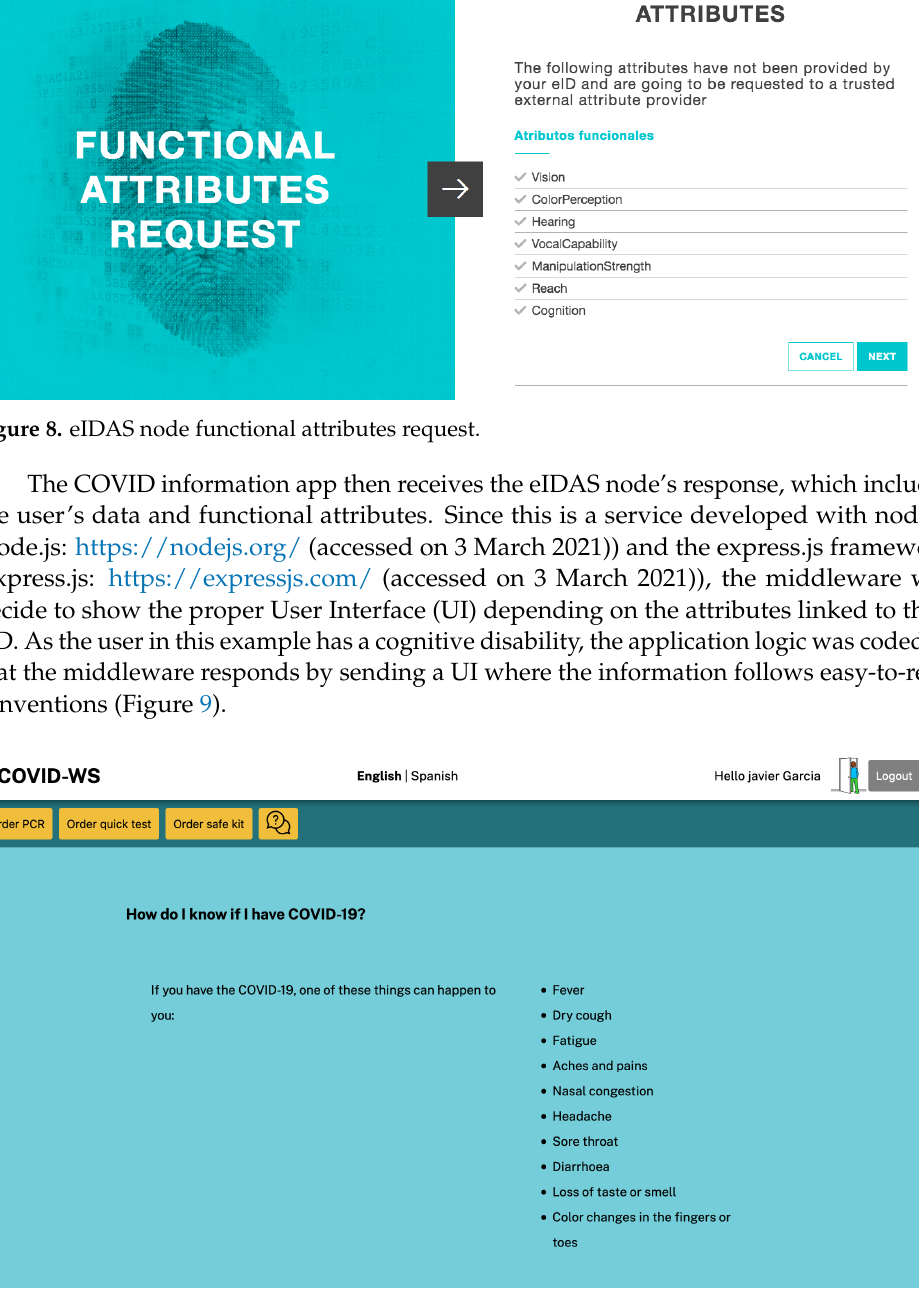
Figure 9. COVID information service adapted to cognition